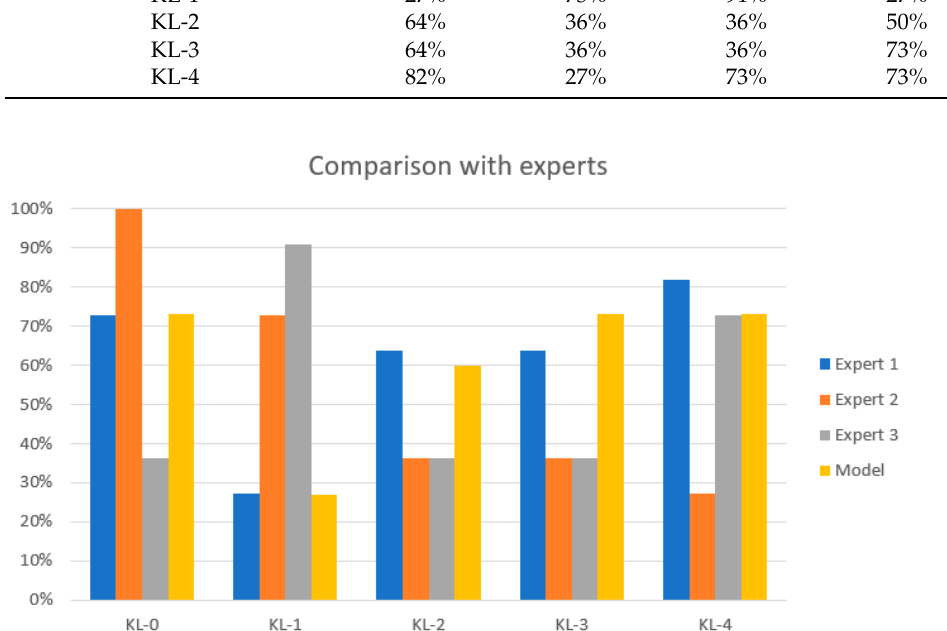
Figure 6. Comparison with the experts. The yellow bar represents the classification results of the proposed model. There is a low classification accuracy for KL-1 and KL-2 grades.